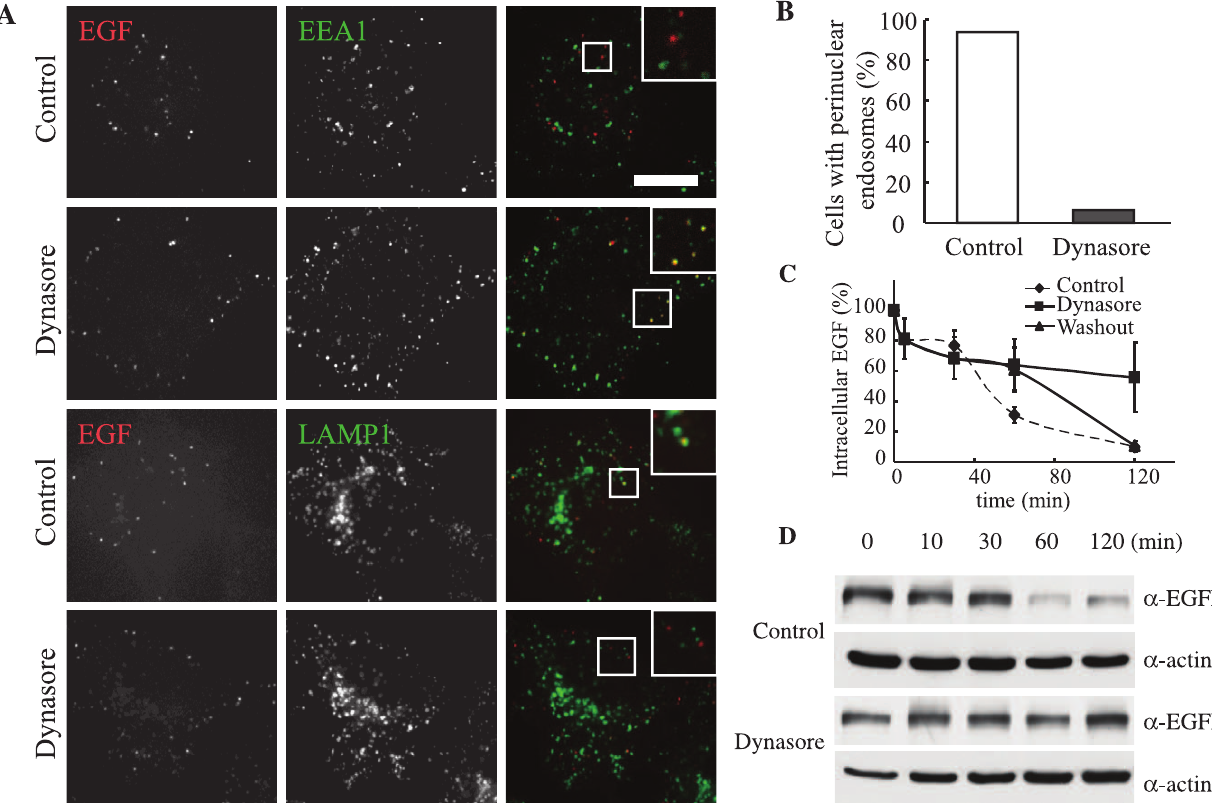
Figure 4. Degradative pathway is inhibited in the early endosome. A , HeLa cells were incubated with Alexa555-EGF on ice for 1 h, rinsed, and transferred to 37 u C. After 5 min, the media was changed to DMSO- (control) or dynasore-containing media and incubated further for the time period indicated. Cells were fixed and stained using anti-EEA1 or anti-LAMP1 (Santa Cruz Biotechnology, Santa Cruz, CA) antibody. B , The cells displaying localized endosomes were manually counted. N=80 cells. C , Cells were incubated with biotin-conjugated EGF on ice for 1 h and processed as in Figure 1A . Intracellular EGF was measured by ELISA. D, Cells were stimulated by EGF. At the indicated time after stimulation, cells were lysed and subjected to SDS-PAGE and an immunoblot analysis using an anti-EGF receptor or